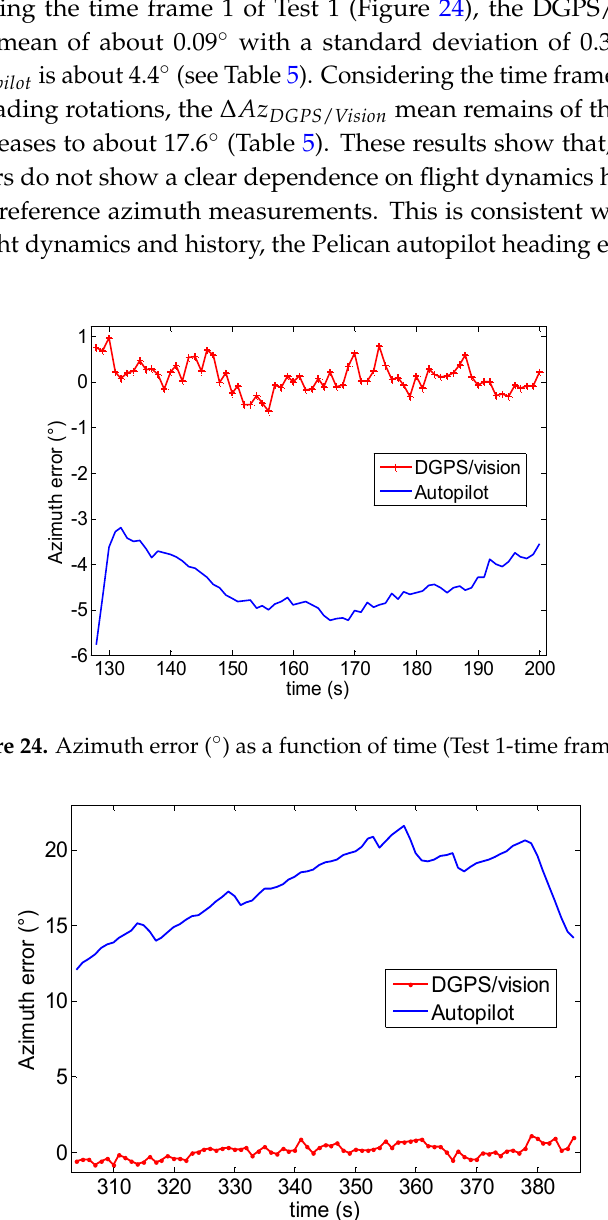
24 of 28 Figure 23. Pitch angle as a function of time (Test 1).